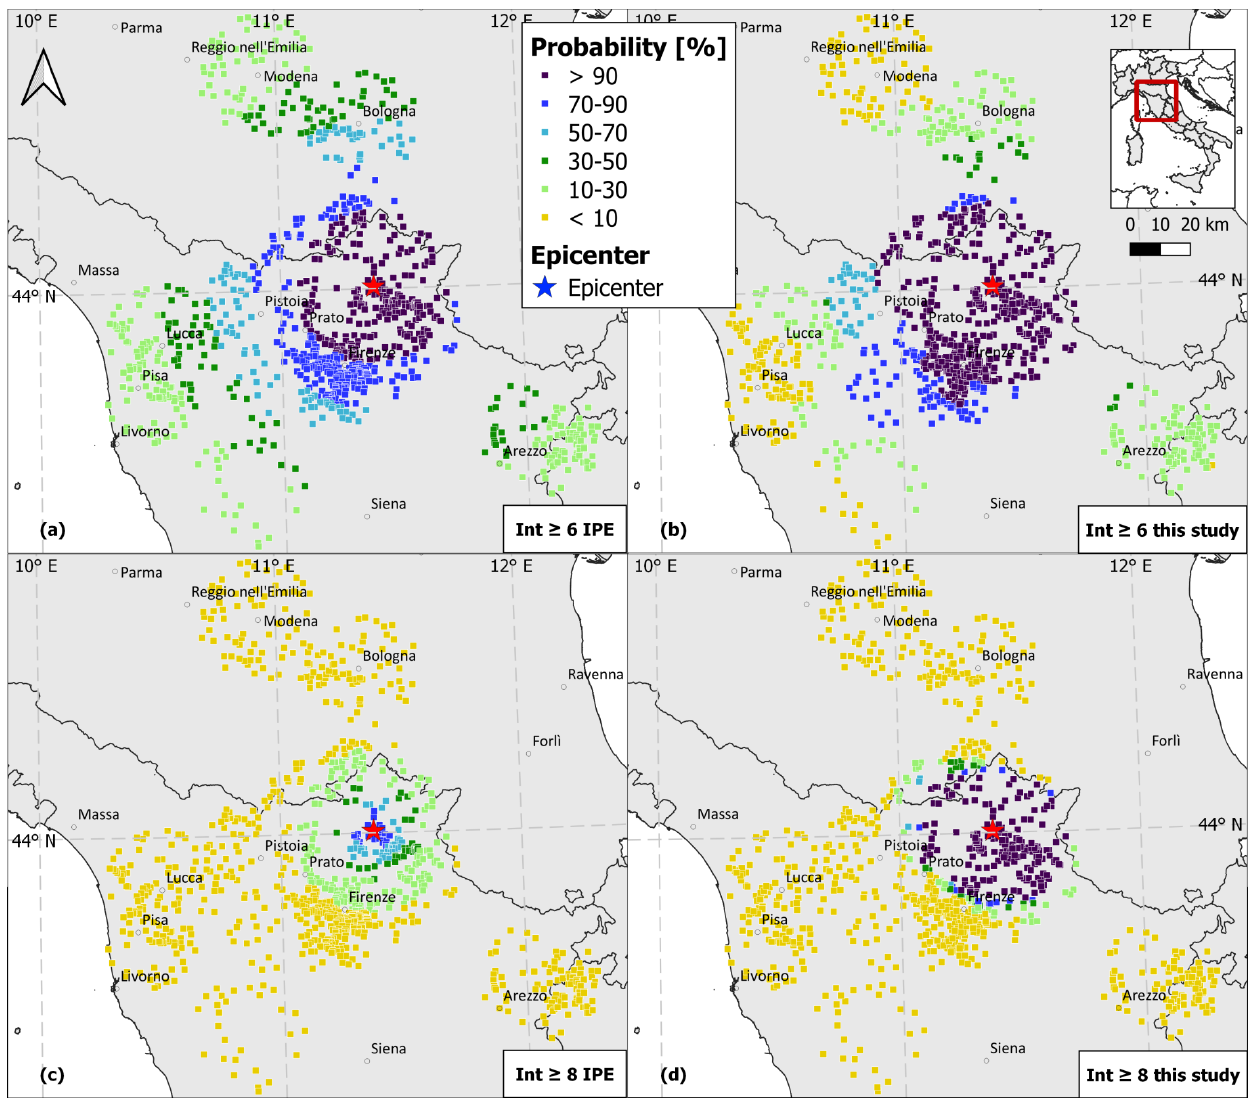
Figure 10. Intensity distribution of the 1542 Mugello earthquake at the 968 considered localities represented as the probability of being greater than or equal to intensity 6 with (a) the IPE alone and (b) this procedure and of being greater than or equal to intensity 8 with (c) the IPE alone and (d) this